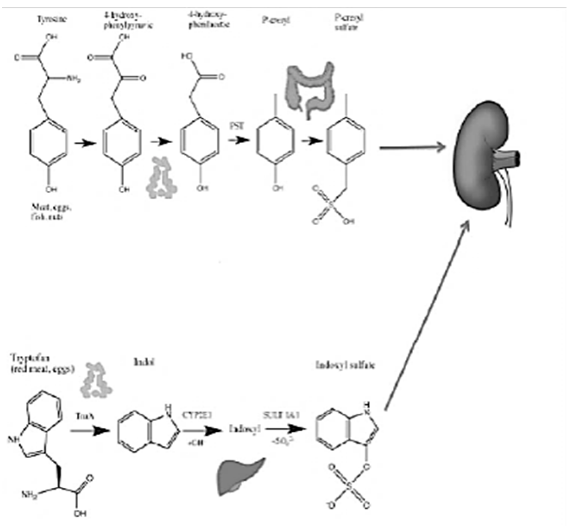
Figure 1. PCS and IS (De Mauri, AOU della Carit à , Novara, Italy). In addition to their toxicity in CKD, caused by their accumulation in the circulation, they have a strong greed for albumin, so they are not effectively eliminated using